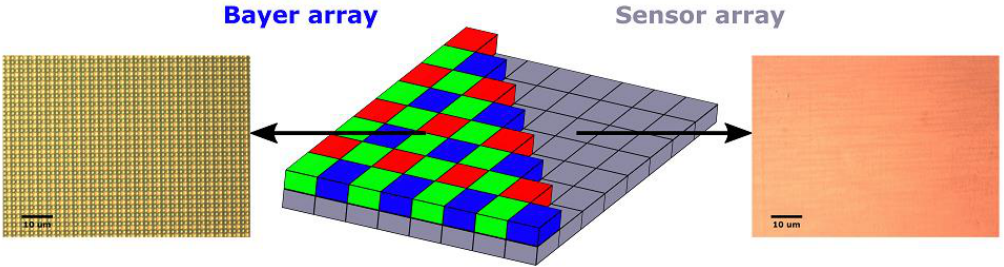
Figure 1. A schematic ( Centre ) of the Bayer filter array and its positioning on the photodetector array. Also shown are microscope images of the PiCam sensor pre- ( Left ) and post- ( Right ) Bayer removal process.